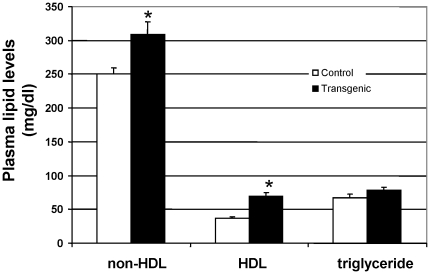
Plasma lipid levels of female transgenic and non-transgenic (control) littermates on the B6.apoE−/− background.Blood was collected from overnight fasted mice fed a chow diet. Values are mean ± SE of 5 transgenic and 8 non-transgenic mice. * P<0.05 vs. non-transgenic littermates.